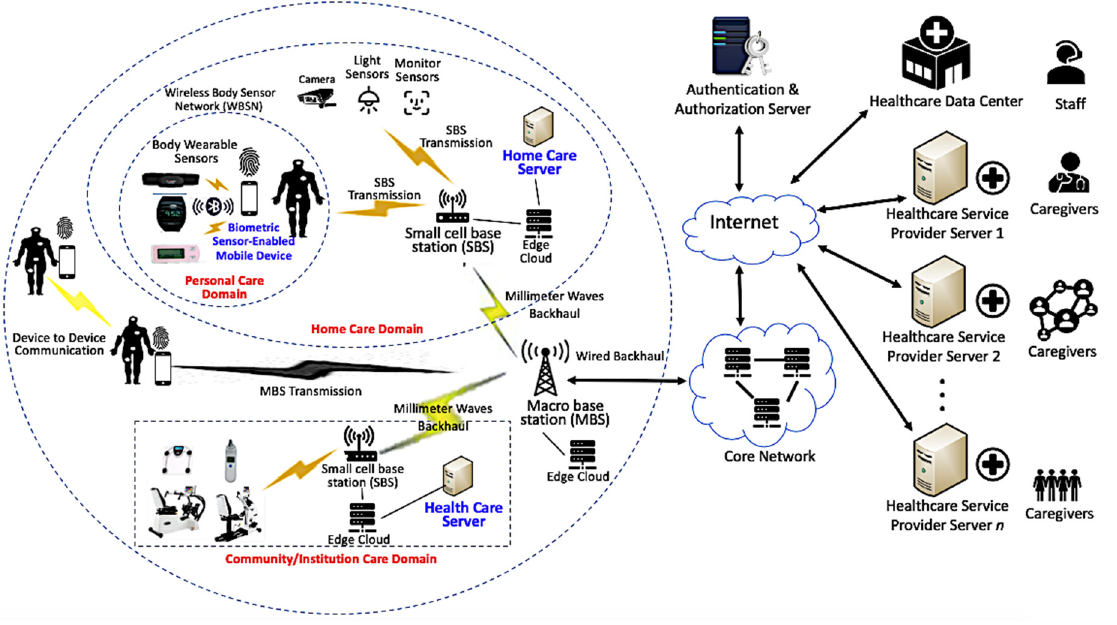
Figure 2. The proposed system model.